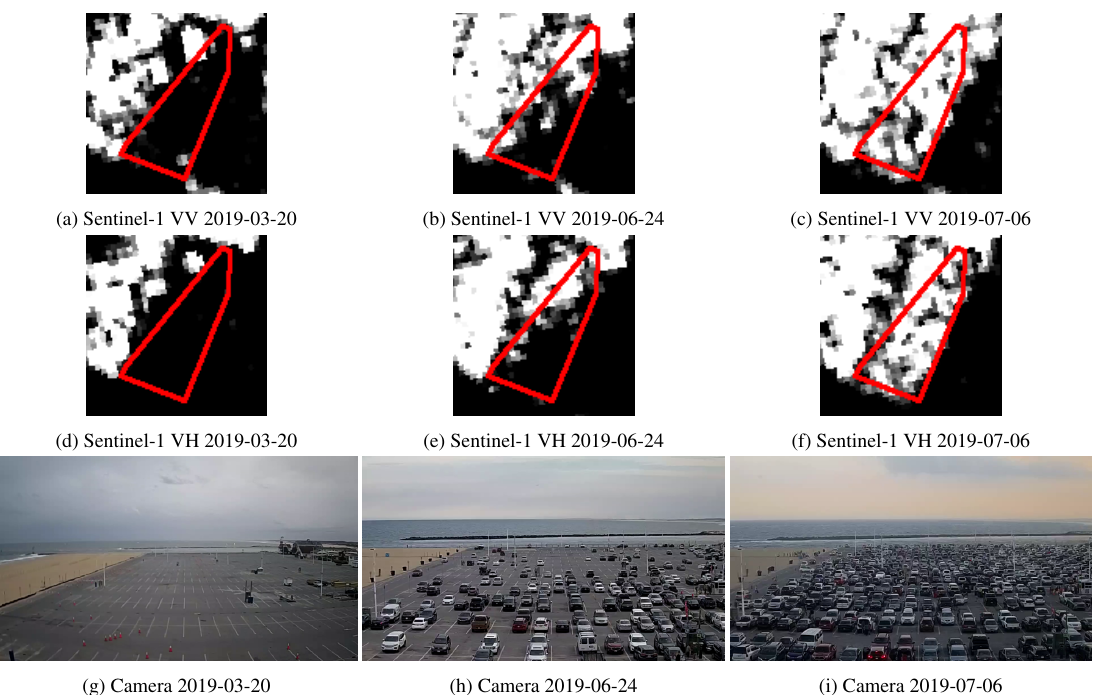
Figure 3. Extracts of the image series in the validation site, from low occupancy to near full occupancy. The VV channel has been normalized between 0.06 and 0.18 and the VH channel has been normalized between 0.02 and 0.06. The red polygon represents the parking mask: in our case, it is the intersection of the parking shape with the Sentinel-1 image footprint as the image does not cover the whole parking. Parking occupancy was estimated by observing the pixels inside the red polygon